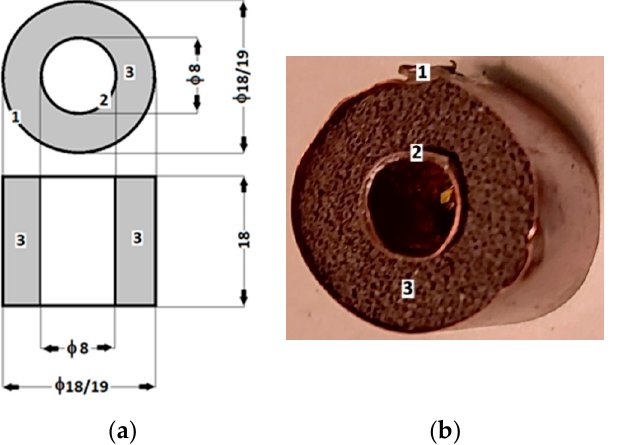
Figure 5. Manufacture of the cylindrical capacitors: ( a ) sketch of the shape and dimensions; ( b ) pho-